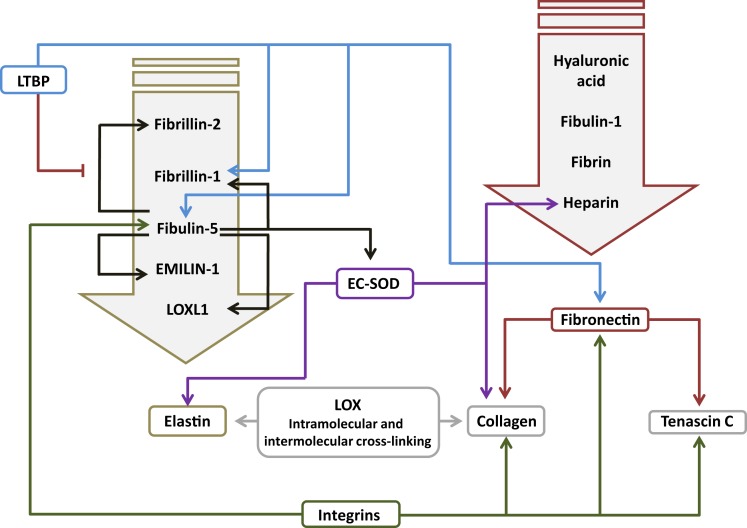
Interactions between components of the extracellular matrix in the lung. The primary interacting molecules for elastin and fibronectin are collected together above the respective target molecules in the downward-pointing block arrows. Abbreviations: EC-SOD, extracellular superoxide dismutase; EMILIN-1, elastin microfibril interfacer 1; LOX, lysyl oxidase; LOXL1, lysyl oxidase-like 1; LTBP, latent transforming growth factor-β-binding protein.